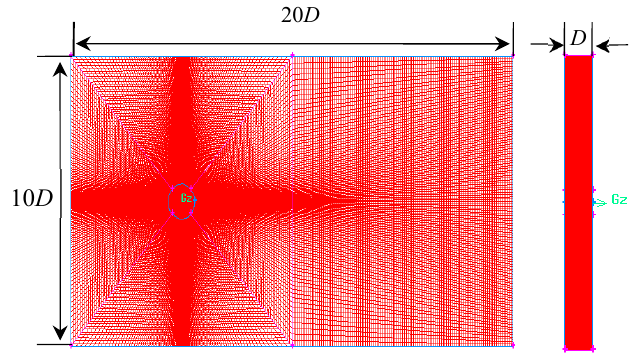
Figure 4. Computation of the domain meshes.